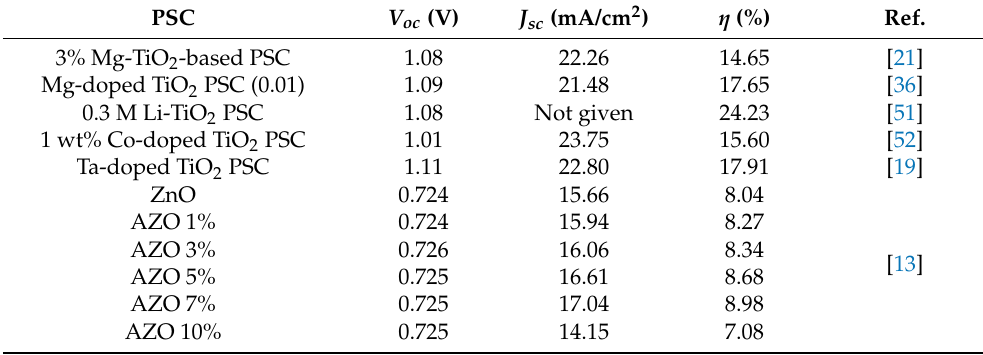
Table 5. Comparison of different metal-doped titania based PSCs’